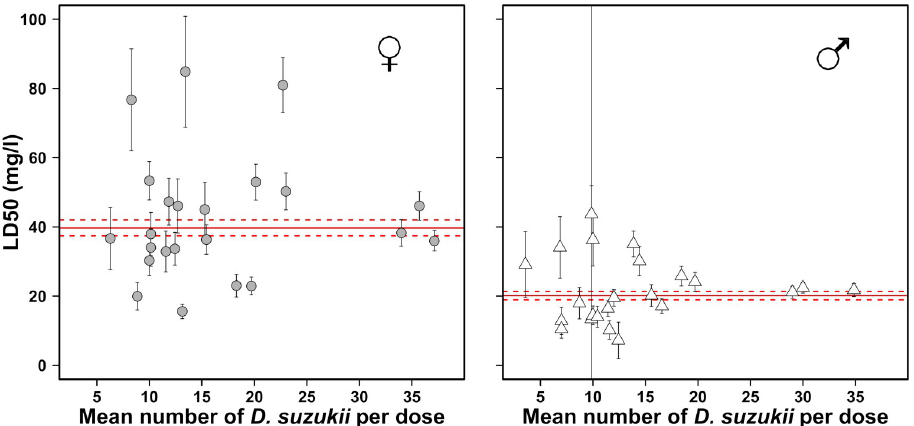
Fig 5. Effect of the mean number of individuals tested per dose on LD 50 in a D . suzukii population. Distribution of LD 50 values and associated 95% confidence intervals after 24 h of tarsal exposure of 24 to 48 hour-old adults to phosmet, according to the number of individuals tested for females (left panel) and males (right panel). The continuous red line indicates the LD 50 value computed on pooled individuals as one unique bioassay and the dashed lines show the corresponding 95% confidence interval.